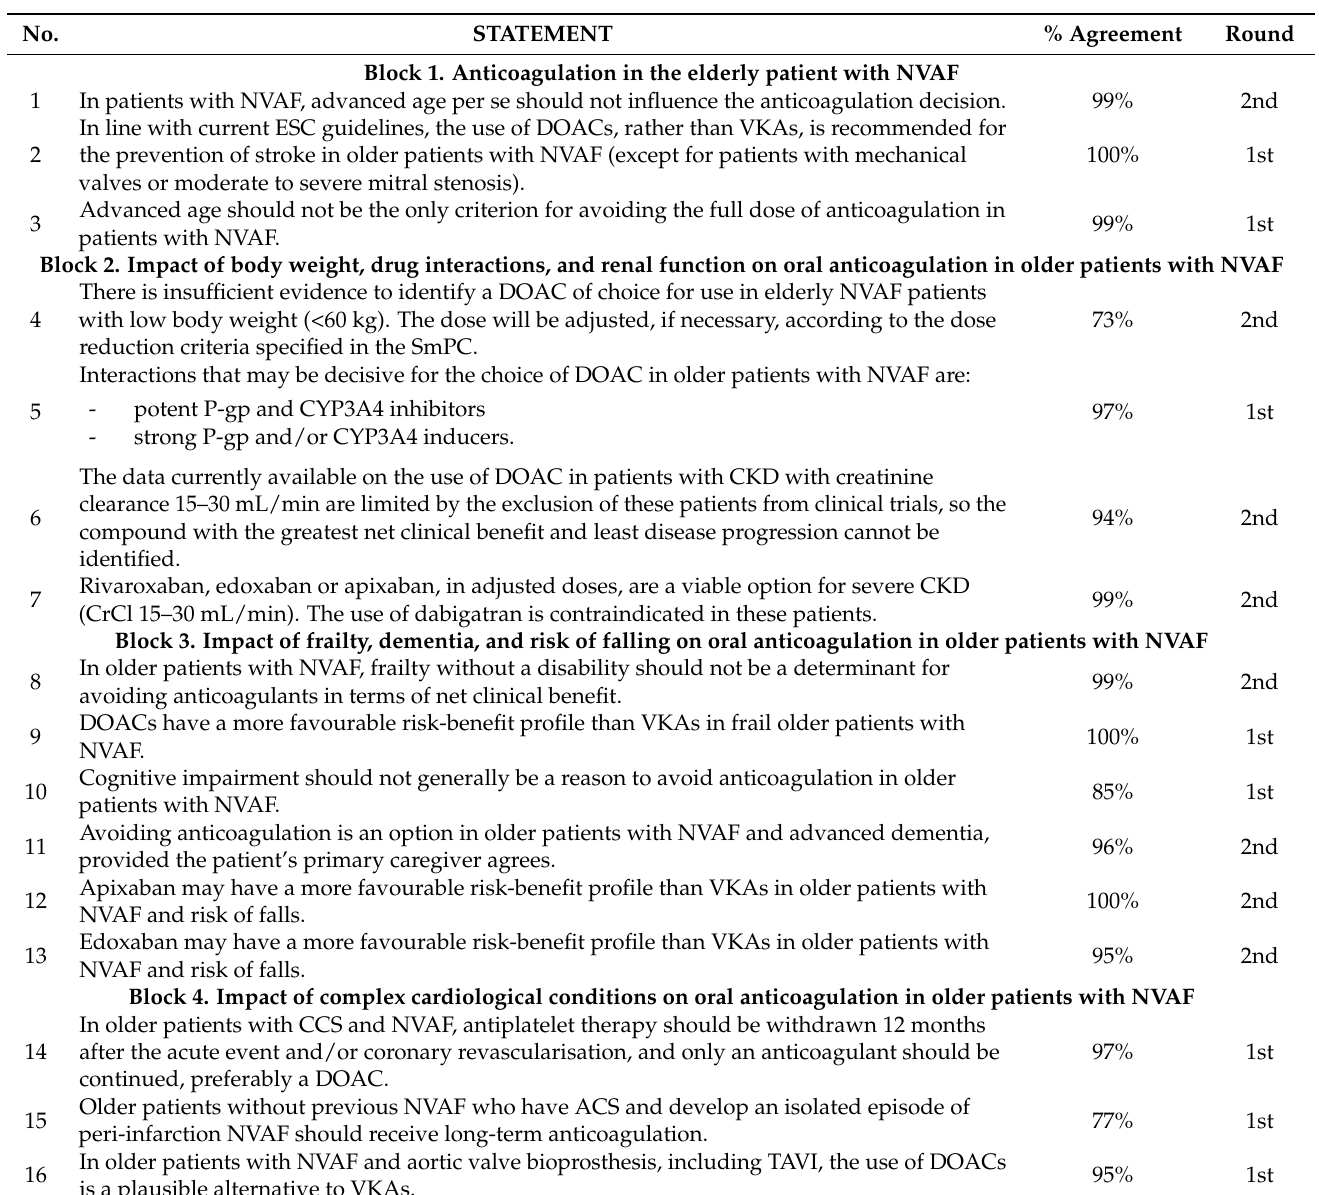
Table 2. Percentage of agreement on Delphi-type statements on oral anticoagulation in elderly patients (>75 years) with